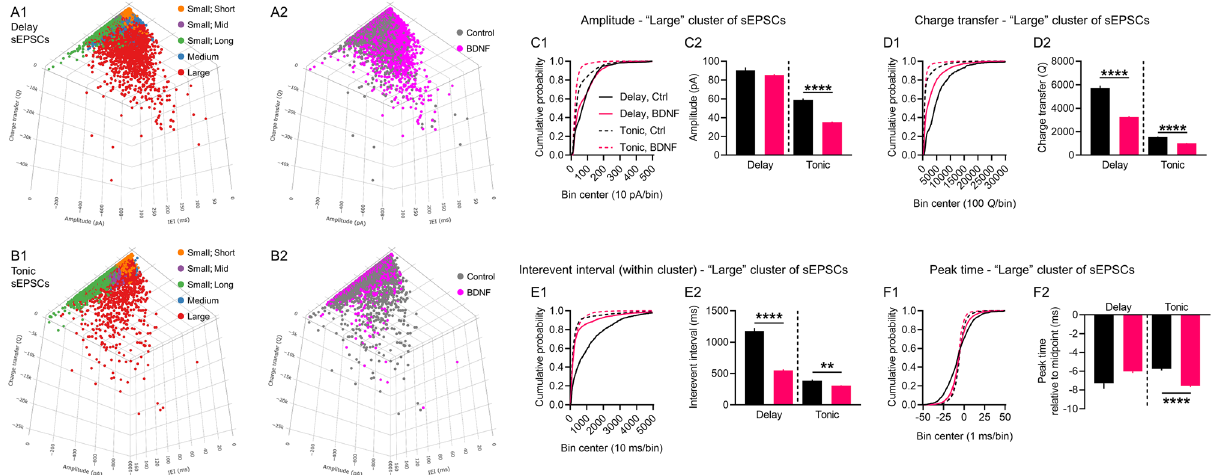
Figure 5. Cluster analysis of spontaneous EPSCs in delay and tonic-firing superficial dorsal horn neurons. Three dimensional representations of the sEPSCs in ( A1 , A2 ) delay neurons and ( B1 , B2 ) tonic neurons plotted based on interevent interval (x-axis), amplitude (y-axis), and charge transfer (z-axis). Mapping of the clustering results and treatment shown for the total sample of sEPSCs. The sEPSCs in each neuron were clustered independently from the other neurons. Optimal partitioning around medoids identified 3 primary clusters present in all neurons in both treatment conditions (naming based on amplitude; interevent interval): small; short, small; long, and large. Two additional clusters were identified in some neurons, but were not present in all neurons in both conditions: small; mid and medium. Neurons sampled: 19 delay (5 control, 14 BDNF); 9 tonic (5 control, 4 BDNF). Total number of sEPSCs: 33,206 in delay, control; 108,261 in delay, BDNF; 40,658 in tonic, control; 36,521 in tonic, BDNF. The effects of BDNF on sEPSC amplitude, charge transfer (i.e., area under the curve), and peak time were assessed for the 3 primary clusters (large cluster shown, refer to Supplemental Fig. 3 for the two small-amplitude clusters). ( C1 , C2 ) Treatment with BDNF significantly decreased sEPSC amplitudes in tonic neurons, but a significant effect was not observed in the delay neurons. Cumulative distributions of the measured amplitudes shown (left) alongside the means ± standard error of the means (right). ( D1 , D2 ) The BDNF treatment significantly reduced sEPSC charge transfer measures in both delay and tonic neurons. ( E1 , E2 ) Interevent intervals for the sEPSCs within the large cluster were significantly decreased in the BDNF-treated neurons. ( F1 , F2 ) The sEPSC activation kinetics were significantly faster in the BDNF-treated neurons, but no significant effect was observed for the sEPSCs in the delay neurons. Large sEPSC cluster sample sizes: delay neurons control n = 753, BDNF n = 4539; tonic neurons control n = 2348, BDNF n = 2367. Comparisons between means were made using Brown-Forsythe and Welch’s ANOVA tests and Games-Howell post-hoc test. ** P < 0.01, **** P <